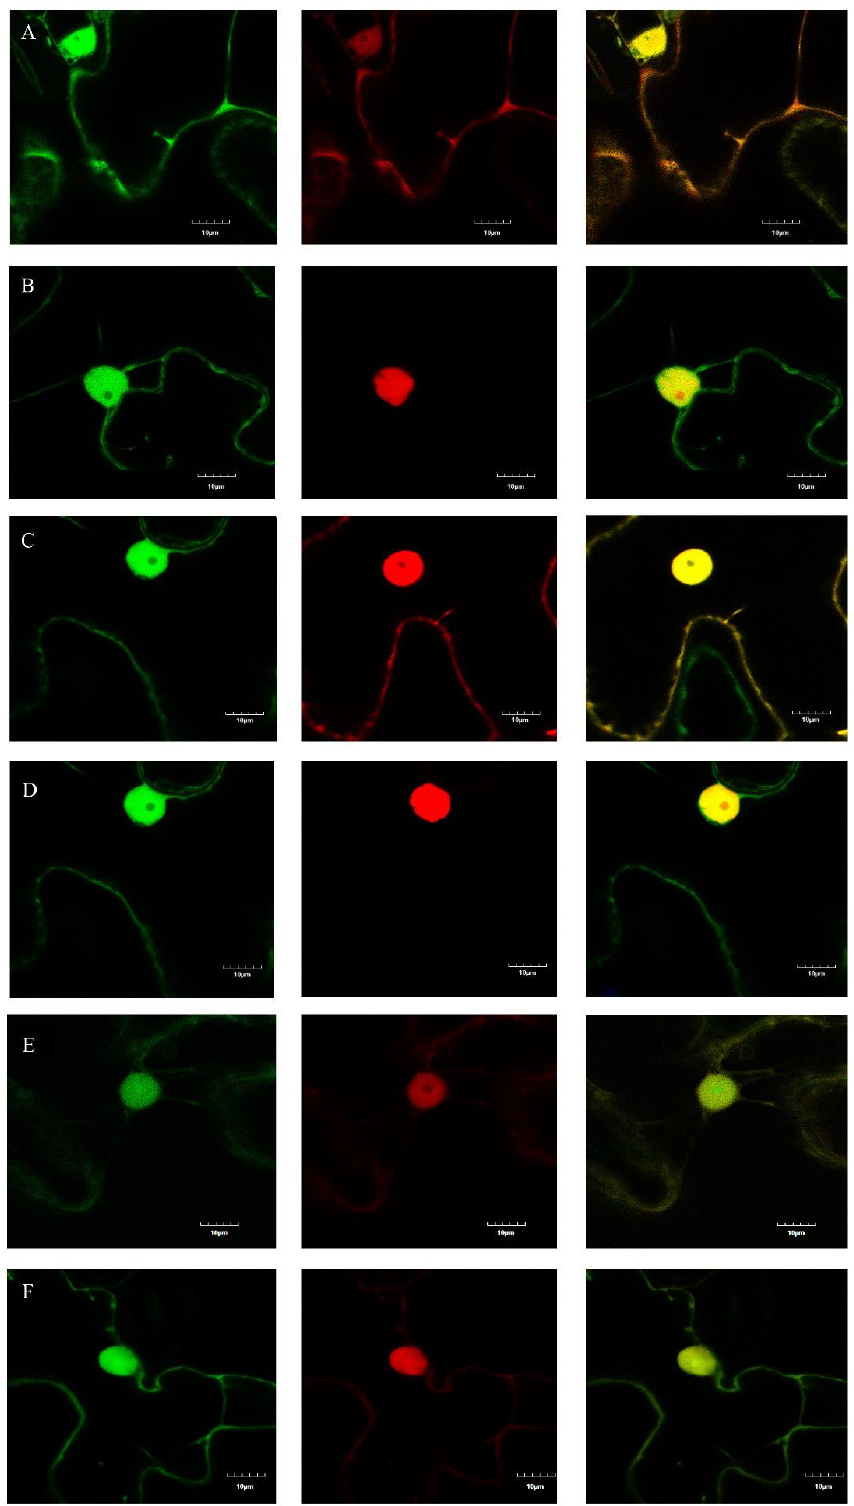
Figure 4. Determination of subcellular localizations of m03915 and m04250. GFP was used to determine the subcellular localizations of m03915 and m04250 by fusion at C-terminal of m03915 and m04250 using confocal microscopy. Free GFP was used as a control. Six true leaf-stage N. benthamiana were infiltrated with Agrobacterium EHA 105 harboring the desired plasmid. Red fluorescent protein